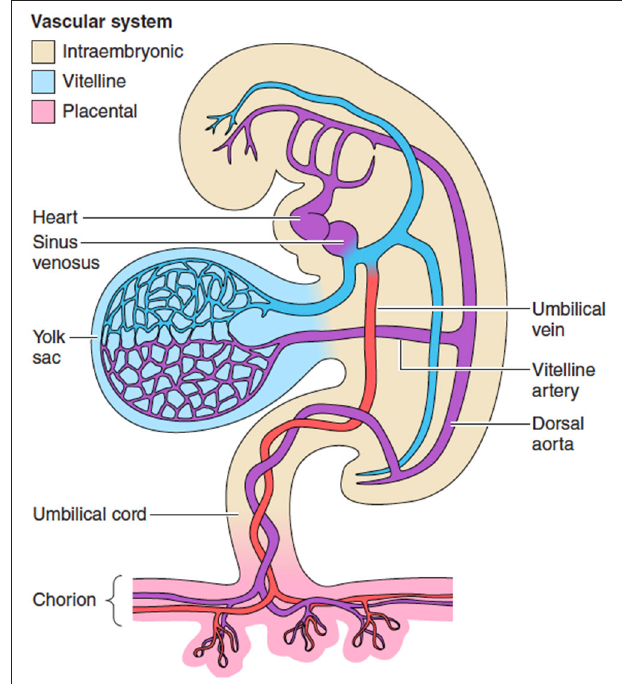
FIGURE 1 | The extravillous circulations. The yolk sac is the first of the extraembryonic membranes to be vascularized, and likely plays a key role in maternal-fetal transport during the period of organogenesis before the chorionic circulation is fully established at ∼ 12 weeks. Changes in the resistance offered by each circulation may affect gene expression and differentiation of the fetal cardiomyocytes. From Burton et al. (2016) with